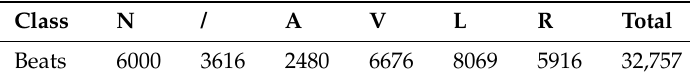
Table 2. Number of beats in the sample